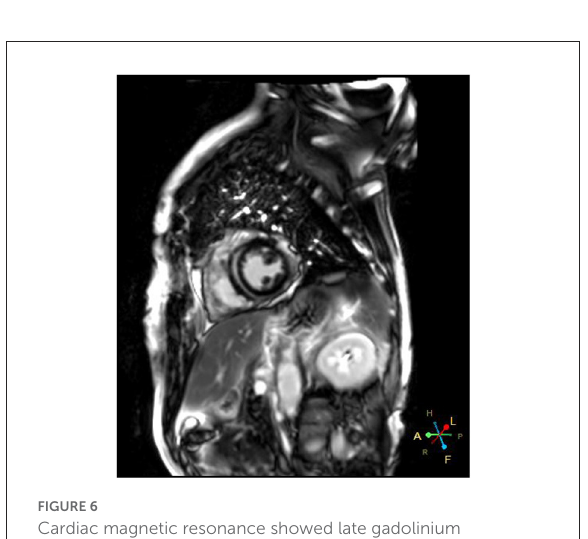
FIGURE6 Cardiac magnetic resonance showed late gadolinium enhancement in left ventricular wall.